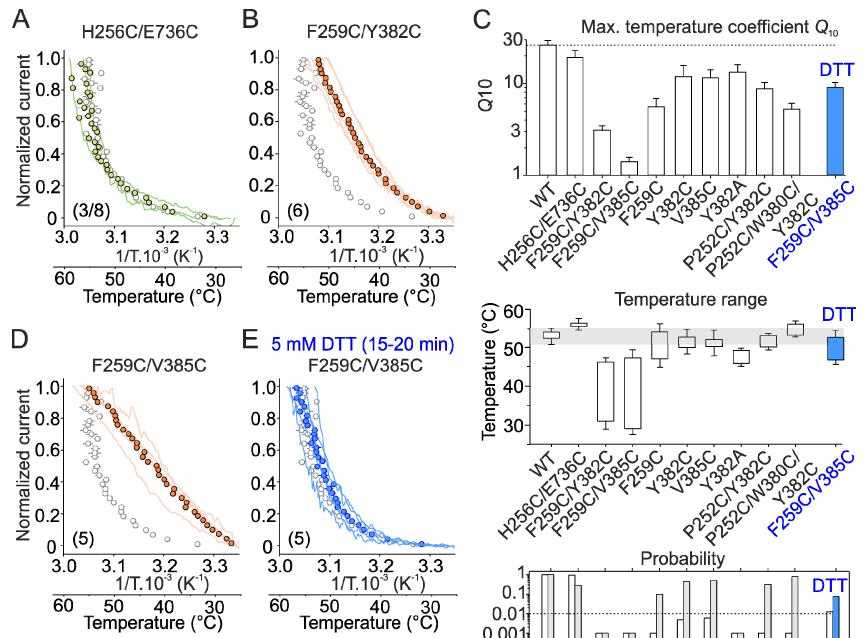
Figure 7. Statistical evaluation of maximum apparent Q 10 and the estimated temperature thresholds for the cysteine mutants. ( A , B ) Heat responses from HEK293T cells expressing the indicated double cysteine mutants, normalized to the maximum amplitude with average values overlaid (colored circles with gray error bars indicating S.E.M.). The average current for wild-type TRPV3 is overlaid for comparison as empty circles with grey bars indicating mean ± S.E.M. Notice, that in the H256C/E736C mutant, only 3 out of 8 cells could be included in the statistics. ( C ) Summary of the maximum temperature coefficient Q 10 values for the measured mutants, compared with wild-type TRPV3 (WT). The horizontal dotted line indicates average maximum Q 10 of WT. Middle, average temperature ranges over which Arrhenius plot of the heat-induced currents was linear and used for the estimation of the maximum Q 10 . Horizontal grey area indicates the upper and lower limits of the temperature range for WT. Below, the probabilities obtained from the t -tests that were performed in order to determine if there was a significant difference between the Q 10 (white vertical bars) and the lower temperature limit for the maximum Q 10 estimation (grey vertical bars) of WT and the individual mutants. The level of significance p = 0.01 is indicated with a dotted horizontal line. Notice the narrow temperature interval used to estimate the parameters for the H256C/E736C mutant ( C , middle panel). ( D , E ) Normalized heat responses from the F259C/V385C mutant measured from untreated cell ( D ) and from cells pretreated with dithiothreitol, DTT, for 15–20 min ( E ). The average current for WT is overlaid for comparison as empty circles with grey bars indicating mean ± S.E.M. The number of cells is indicated in parentheses.